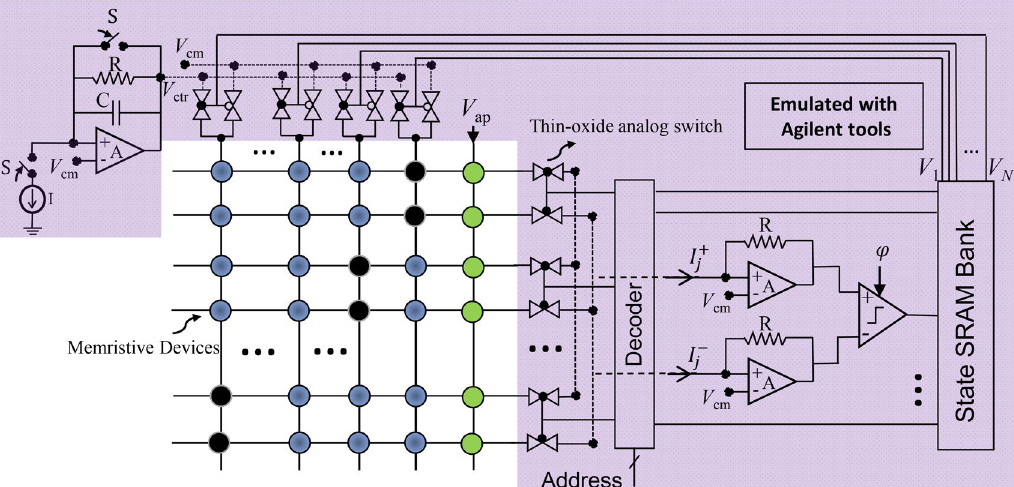
Figure 2. The current-mode recurrent circuit that implements the weight annealing of discrete-time Hopfield networks with programmable analog memories. The green circles show the bias weights ( T b i ) while the black circles implement self-feedback weights ( T ii ), and the rest of them denote the main synaptic weights ( T ij , i = j ). A constant ‘on’ voltage, which is the same as the tuning voltage, drives the bias column. We control the applied voltage to the rest of the devices during the runtime to adjust the synaptic weights (exponentially). Note that V cm is only added to emphasize that the circuit operate on a single- V dd . Values R , C , and I depend on the problem